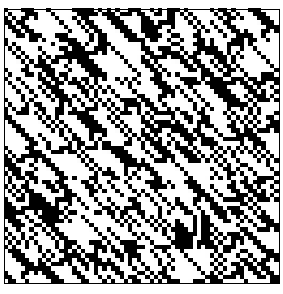
Figure 4: The 64 × 64 matrix L used in